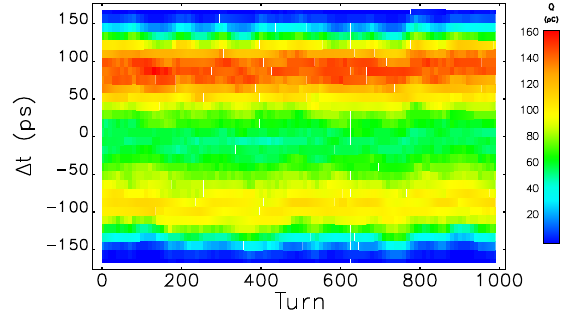
FIG. 13. Charge distribution over 1000 turns from 30-slice analysis for ordinary bunch 0 of a fill with twelve 2-bunch gaps.